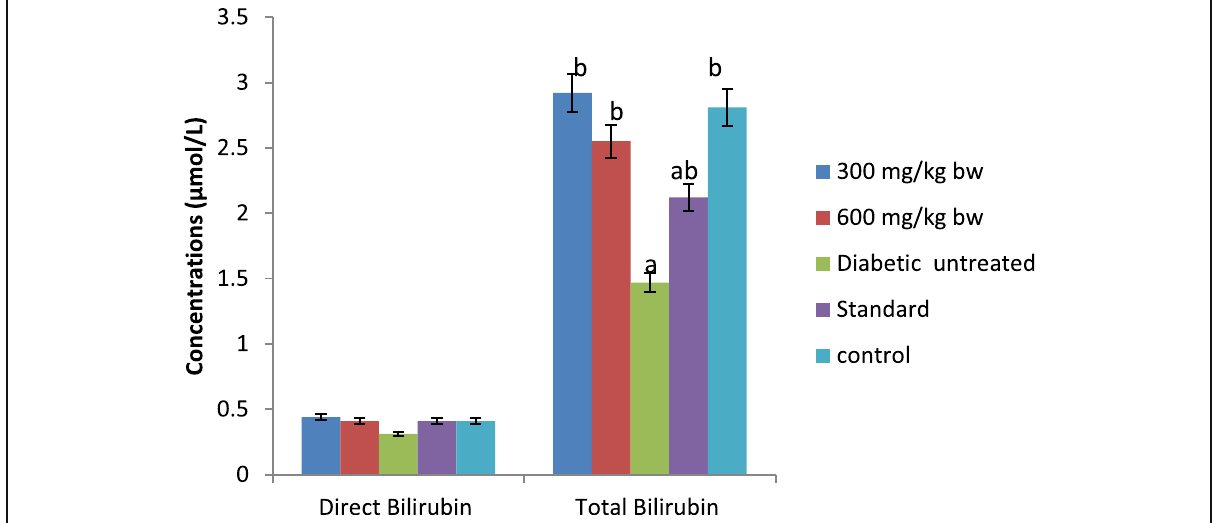
Fig. 4 Effect of Methanol Root Extract of Chromolaena odorata on Serum Bilirubins in Alloxan Induced Diabetic Rats. Each bars represents Mean ± SEM of triplicate determinations. Bars with different alphabets indicate significant difference at ( p <